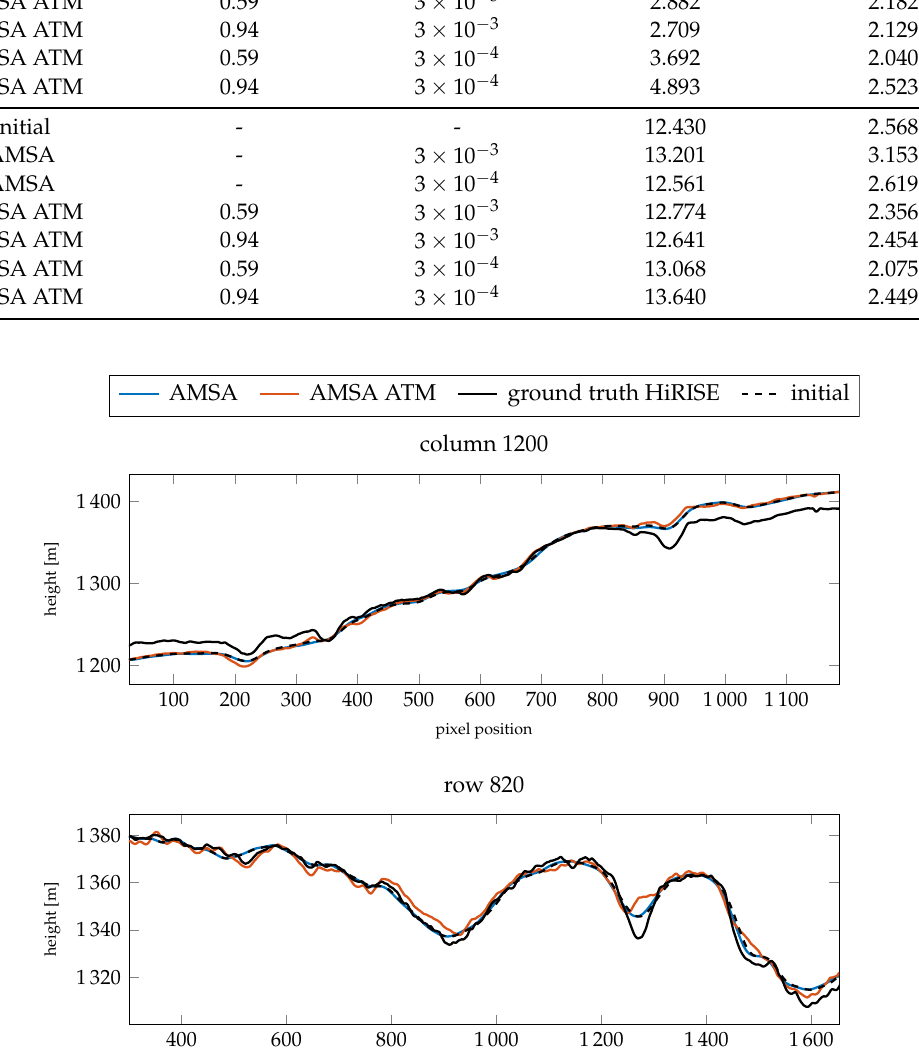
Figure 15. Resulting slopes compared for the two profiles investigated for image K13_058475_2232_XN_43N103W ( γ = 3